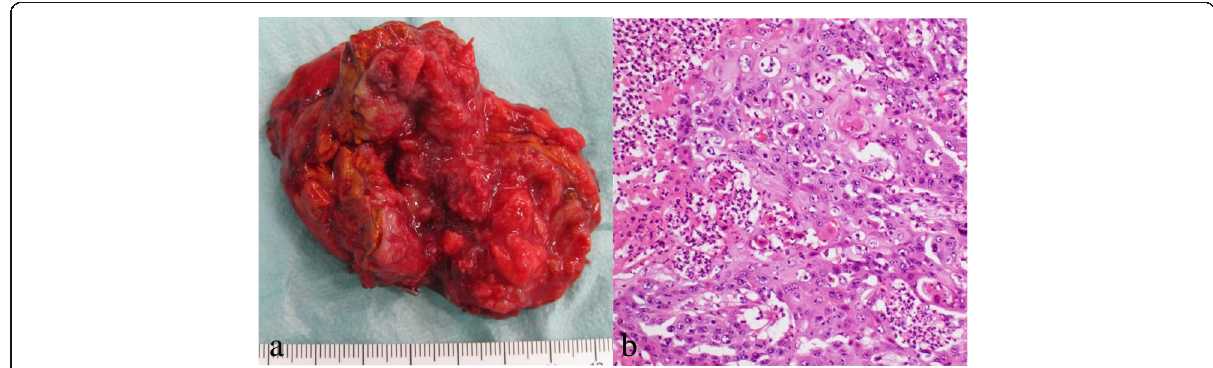
Fig. 4 Resected specimen of the right adrenal mass. a Gross appearance shows a hard, solid mass approximately 2.0 cm in diameter. b Hematoxylin eosin staining shows moderately differentiated squamous cell